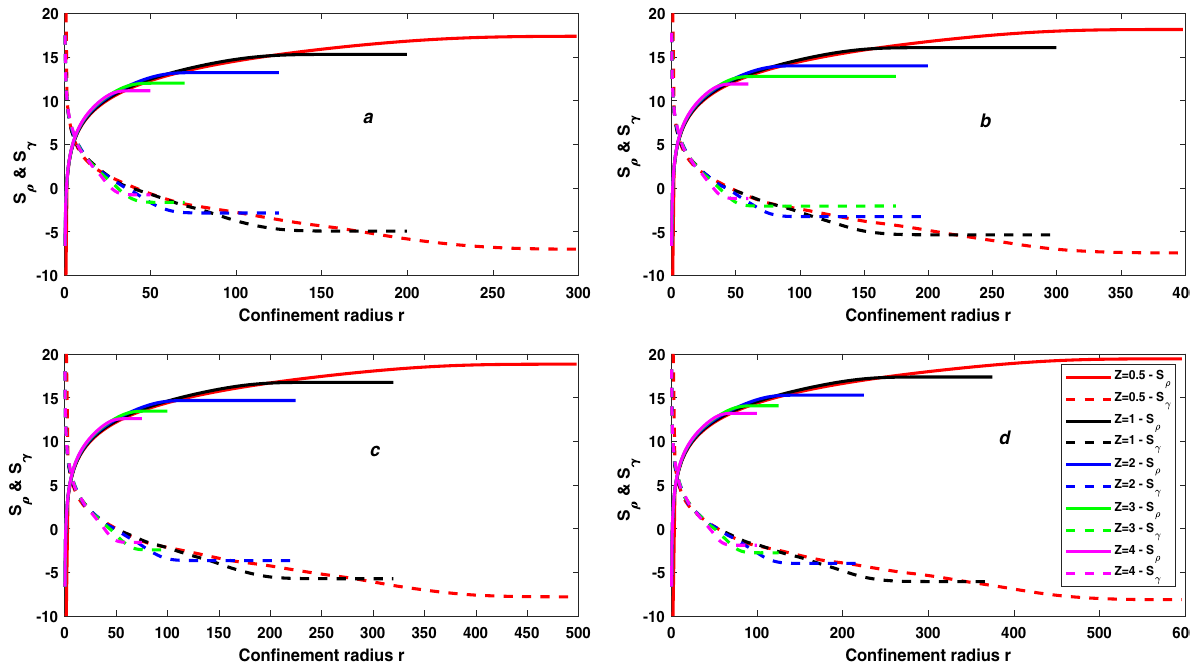
Figure 3. The variation of Shannon entropy in position space S ρ and Shannon entropy in momentum space S γ with confinement radius r and atomic number Z for 7s state ( a ), 8s state ( b ), 9s state ( c ) and 10s state ( d ) of trapped Hydrogen-like